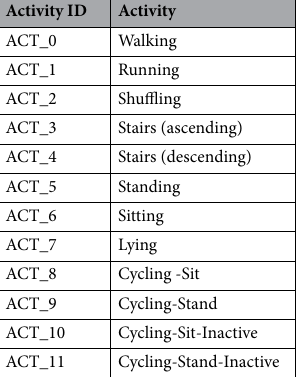
Table 2. A tabular representation of the classes of human activities performed in the HARTH dataset.